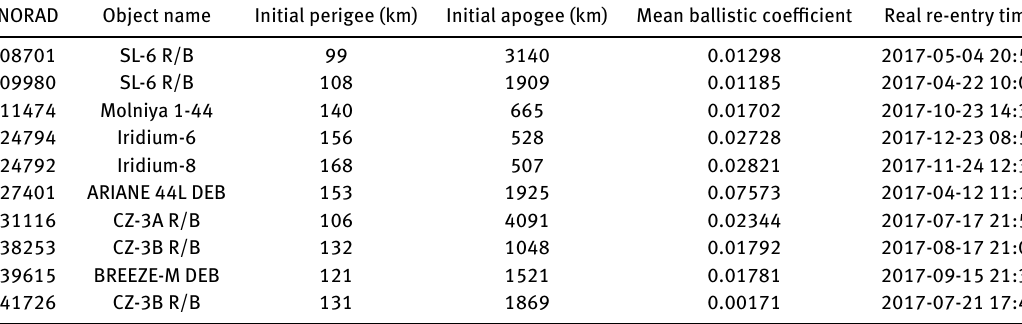
Table 4. Information and real re-entry time of ten test objects